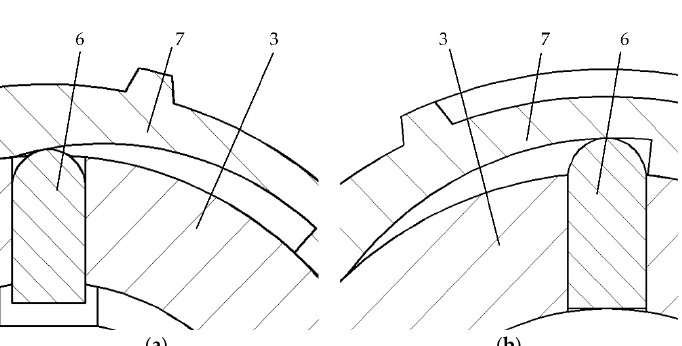
Figure 8. The relative position between the locking tab and the locking ring in ( a ) the locking state, ( b ) the unlocking state. 3—Actuator working cavity, 6—Locking tab, 7—Locking ring.